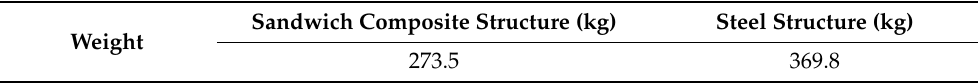
Table 6. Comparison weight between GFRP and steel floor.